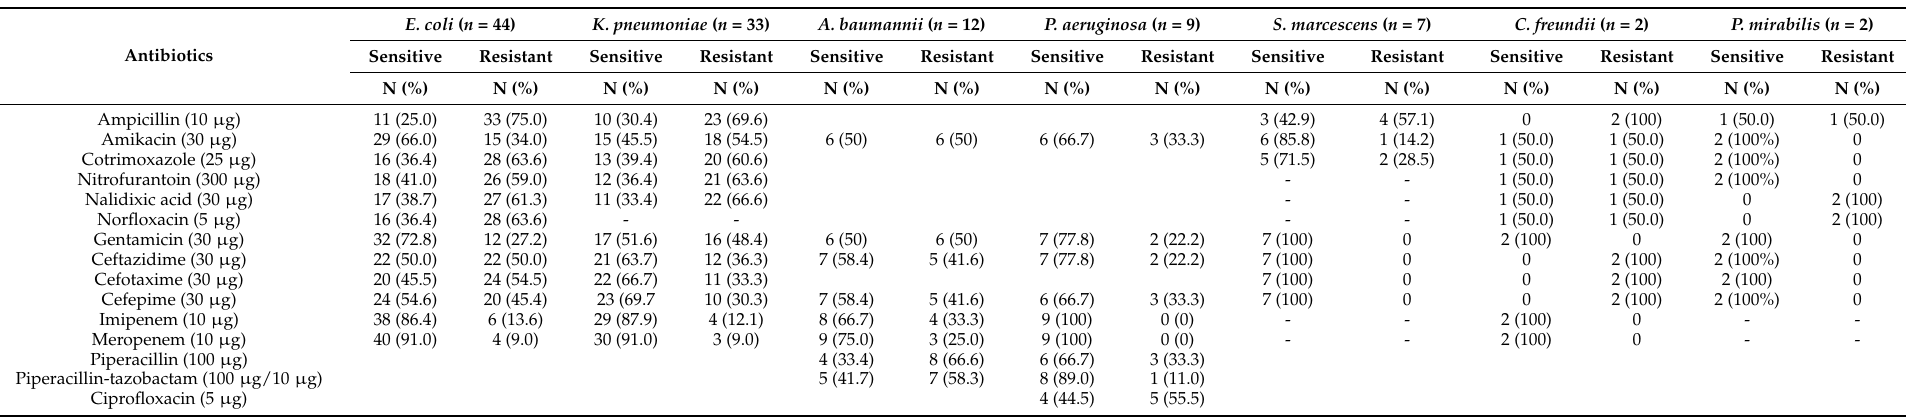
Table 2. Antibiotic susceptibility pattern of Gram-negative bacterial isolates ( n =